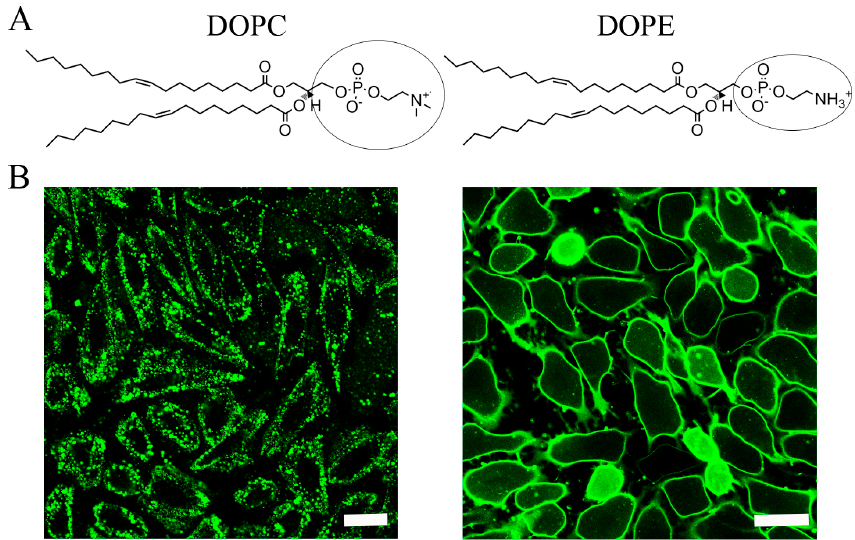
Figure 6. ( A ) Chemical structures of the neutral lipids 1,2-dioleoyl- sn -glycero-3-phosphocholine (DOPC) and 1,2-dioleoyl- sn -glycero-3-phosphoethanolamine (DOPE). ( B ) Fluorescence micrographs of CHO cells treated with liposomes containing DOPC ( left ) or DOPE ( right ) as neutral lipid, DOTAP as cationic lipid, and BODIPY FL-DHPE as fluorescent component (1/1/0.1 mol/mol). Scale bars, 20 µm.